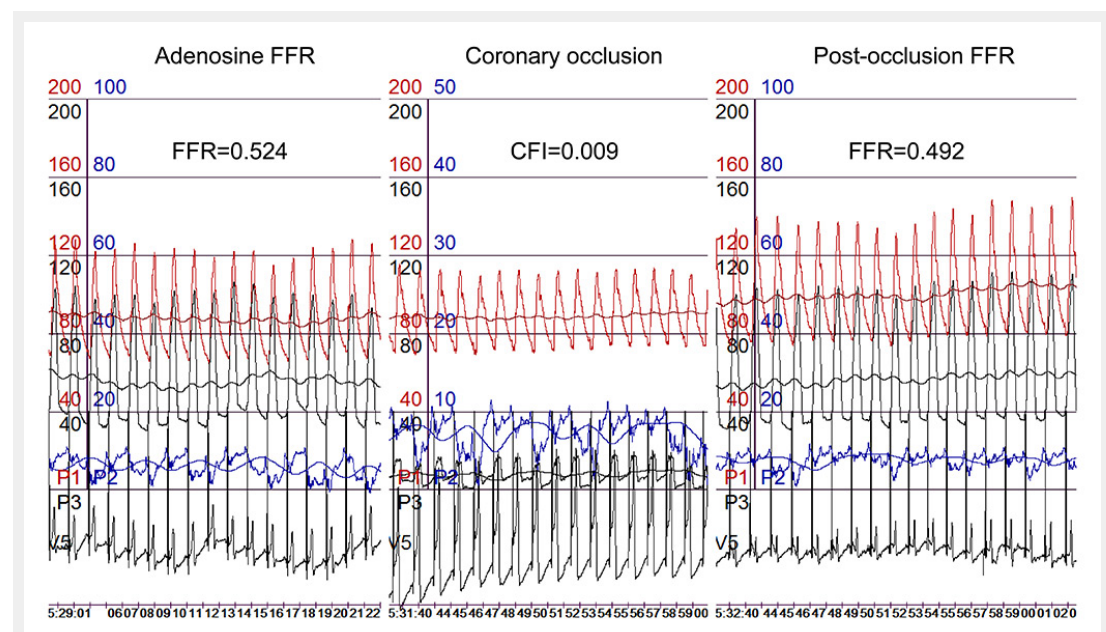
Figure 3 Simultaneous recordings of phasic and mean aortic (P ao for mean pressure in red), distal coronary (P d for mean pressure in black), occlusive coronary (P occl in black), and central venous pressure (CVP in blue), as well as an intracoronary ECG lead. During coronary occlusion, marked ECG ST-segment elevations are visible. CFI = collateral flow index; FFR = fractional flow